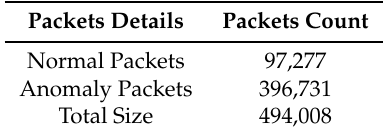
Table 1. KDD99 dataset binary classifications total packets.